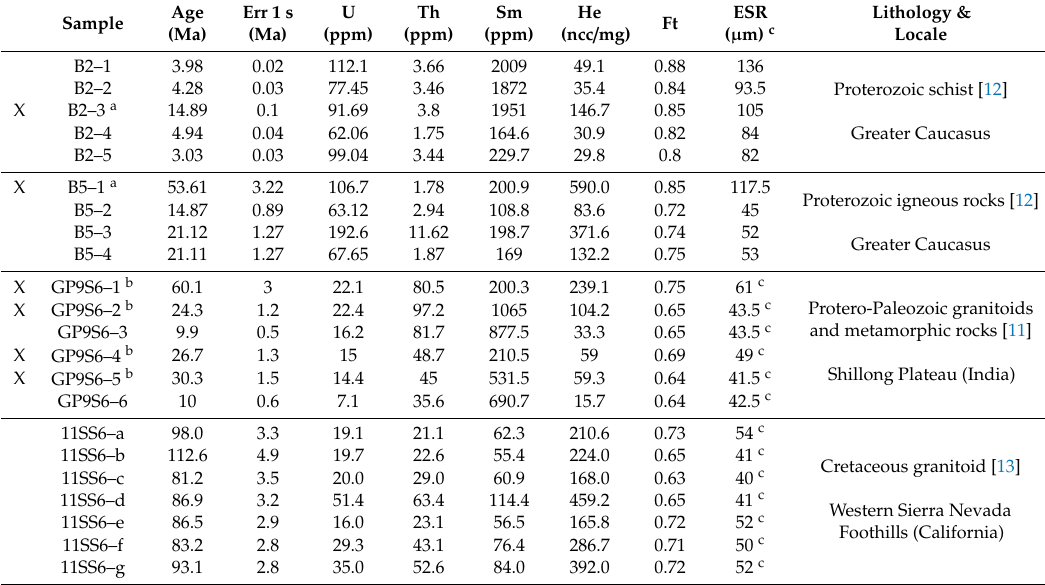
Table 2. Apatite (U-Th) / He data. X in first column indicates that a date was rejected by its